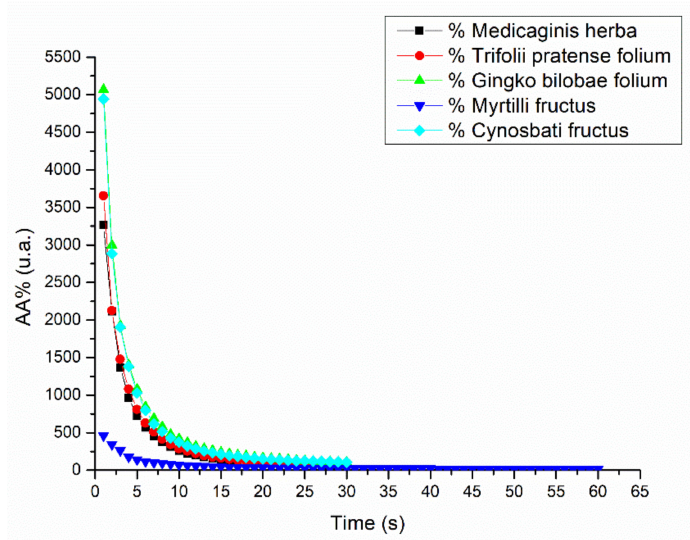
Figure 3. Variation in antioxidant activity values as a function of the reaction time for the stud- ied